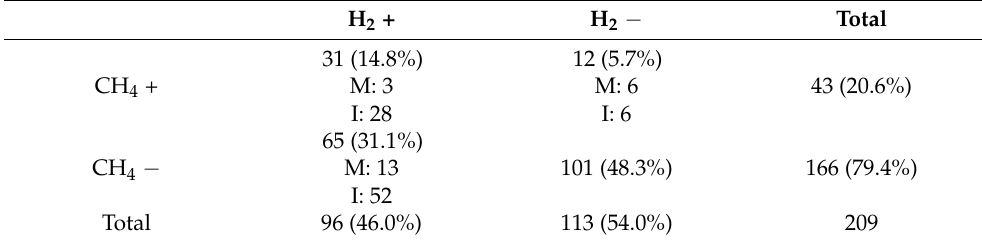
Table 1. Hydrogen (H 2 ) versus methane (CH 4 )